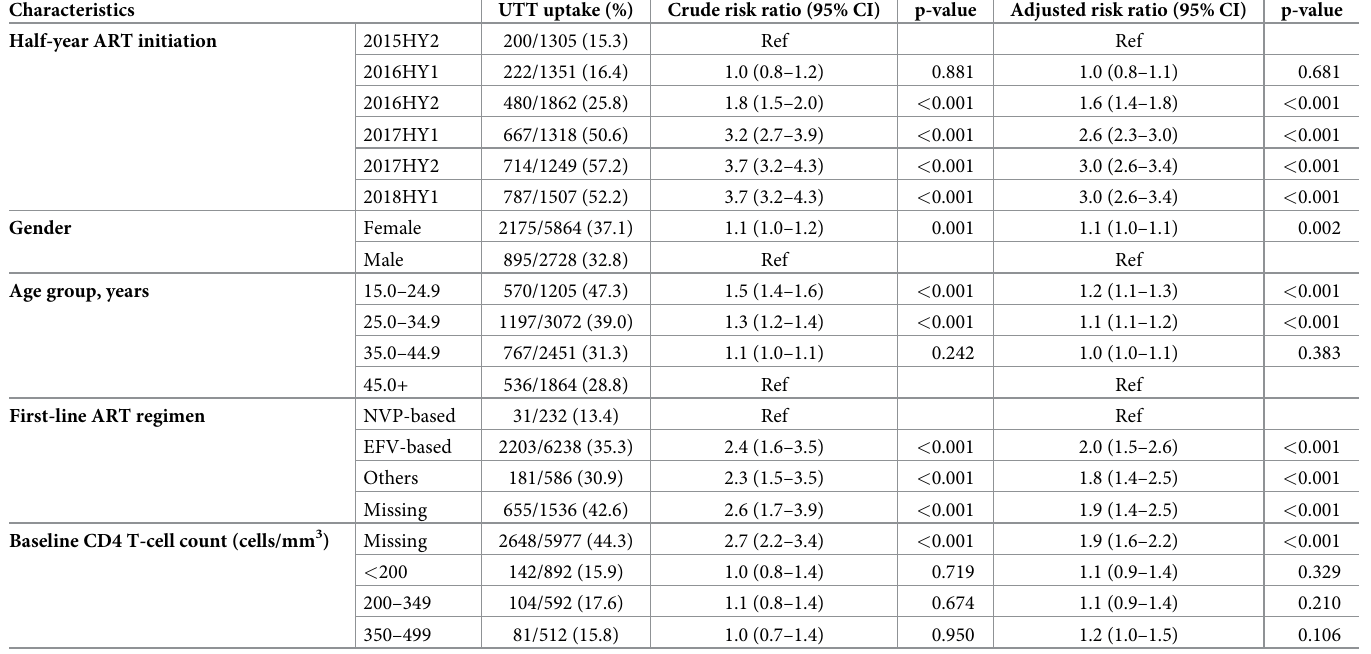
Table 2. Factors associated with uptake of universal test-and-treat, defined as same-day HIV diagnosis and combination antiretroviral therapy start, amongst HIV infected adults using data from the national data warehouse in Kenya (2015HY2 to 2018HY1, N = 8592). Characteristics